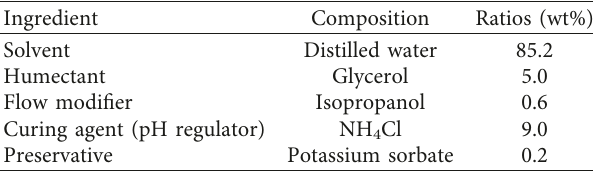
Table 2: Formulation for weakly acidic aqueous printing material. Table 1: Two sets of formulations for powder material with dif-